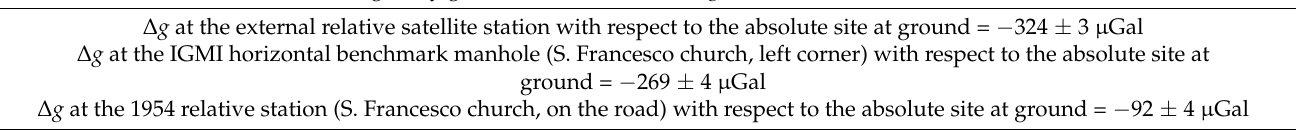
Table 6. Absolute gravity measurements collected at L’Aquila (AQUIg) station during June 2018–October 2018 and October 2020 period by FG5#238 and A10#39 absolute ballistic gravimeters. The combined uncertainties δ tot associated with the g values are also